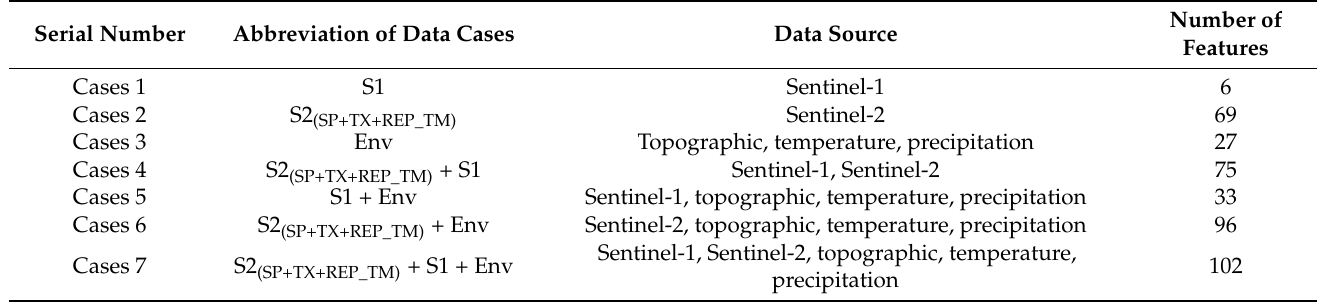
Table 2. Different data cases are designed for tree species classification.